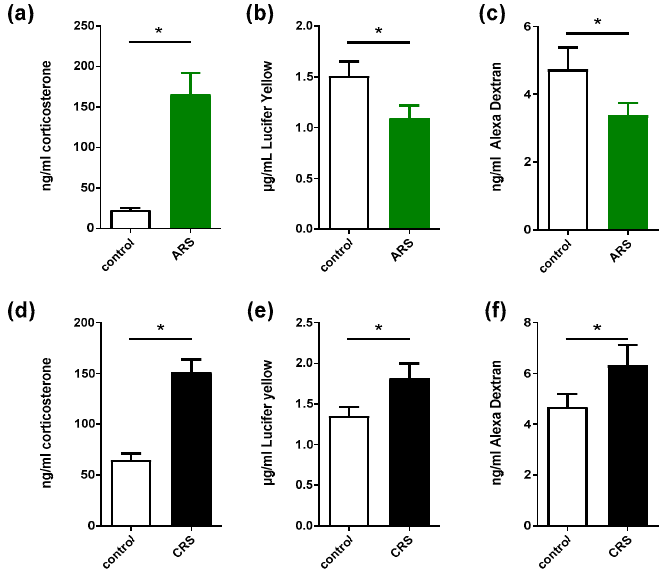
Figure 1. Plasma corticosterone levels and colonic permeability in response to acute (ARS) or chronic (CRS) stress models. ( a , d ): plasma corticosterone levels; ( b , e ) Lucifer yellow levels; ( c , f ): Alexa Dextran concentrations measured in Ussing chambers in control vs. ARS or CRS groups, respectively. Data are presented as means ± SEM. n = 8–20 per group. *, p < 0.05, Student’s t -test.